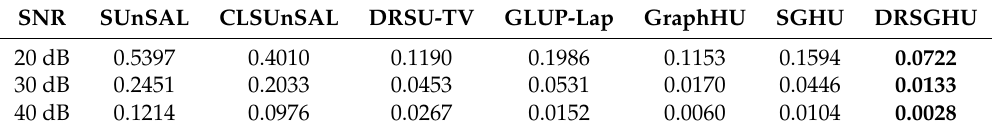
Figure 5. Abundance maps obtained by different methods for the fourth endmember (EM4) in DC2. From left to right: the unmixing results for the noise levels 20 dB, 30 dB and 40 dB. From top to bottom: The unmixing results by SUnSAL, CLSUnSAL, DRSU-TV, GLUP-Lap, GraphHU, SGHU and DRSGHU. Table 3. Relative errors of the estimated fractional abundances of EM4 for different noise levels of